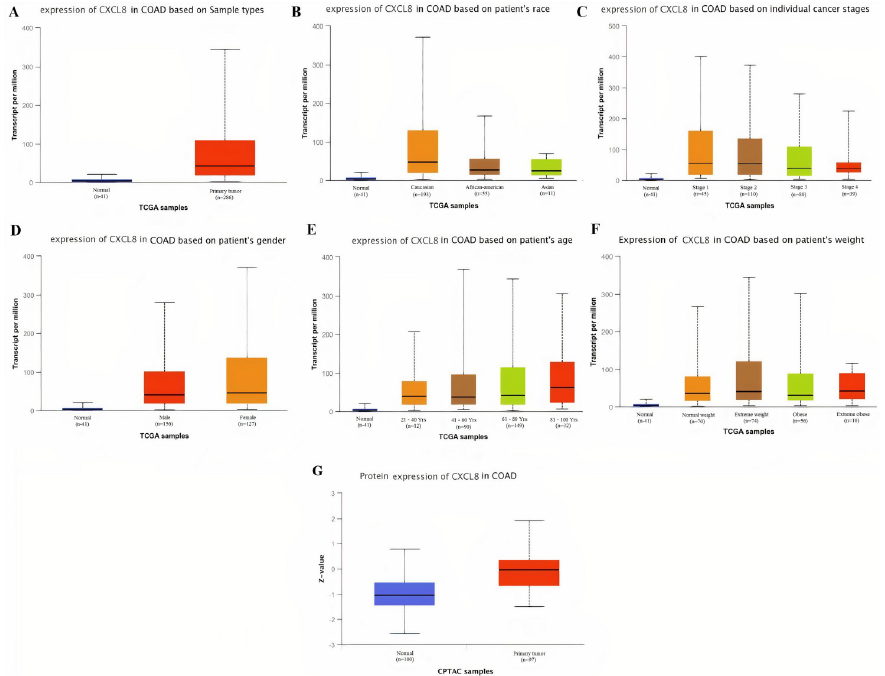
Fig 6. Box plots showing the relative expression levels of CXCL8 in normal and COAD samples of different clinicopathological features via UALCAN database. Relative mRNA expression of CXCL8: (A) in normal individuals and COAD patients; (B) in normal individuals and COAD patients of different races; (C) in normal individuals and COAD patients of different cancer stages; (D) in normal individuals and COAD patients of different genders; (E) in normal individuals and COAD patients of different age groups; and, (F) in normal individuals and COAD patients of different body weights; (G) Relative protein expression of CXCL8 in normal individuals and COAD patients. A p- value of < 0.05 was considered significant. Normal weight = BMI greater than or equal to 18.5 and BMI less than 25, Extereme weight = BMI greater than or equal to 25 and BMI less than 30, Obese = BMI greater than or equal to 30 and BMI less than 40, and Extreme Obese = BMI greater than